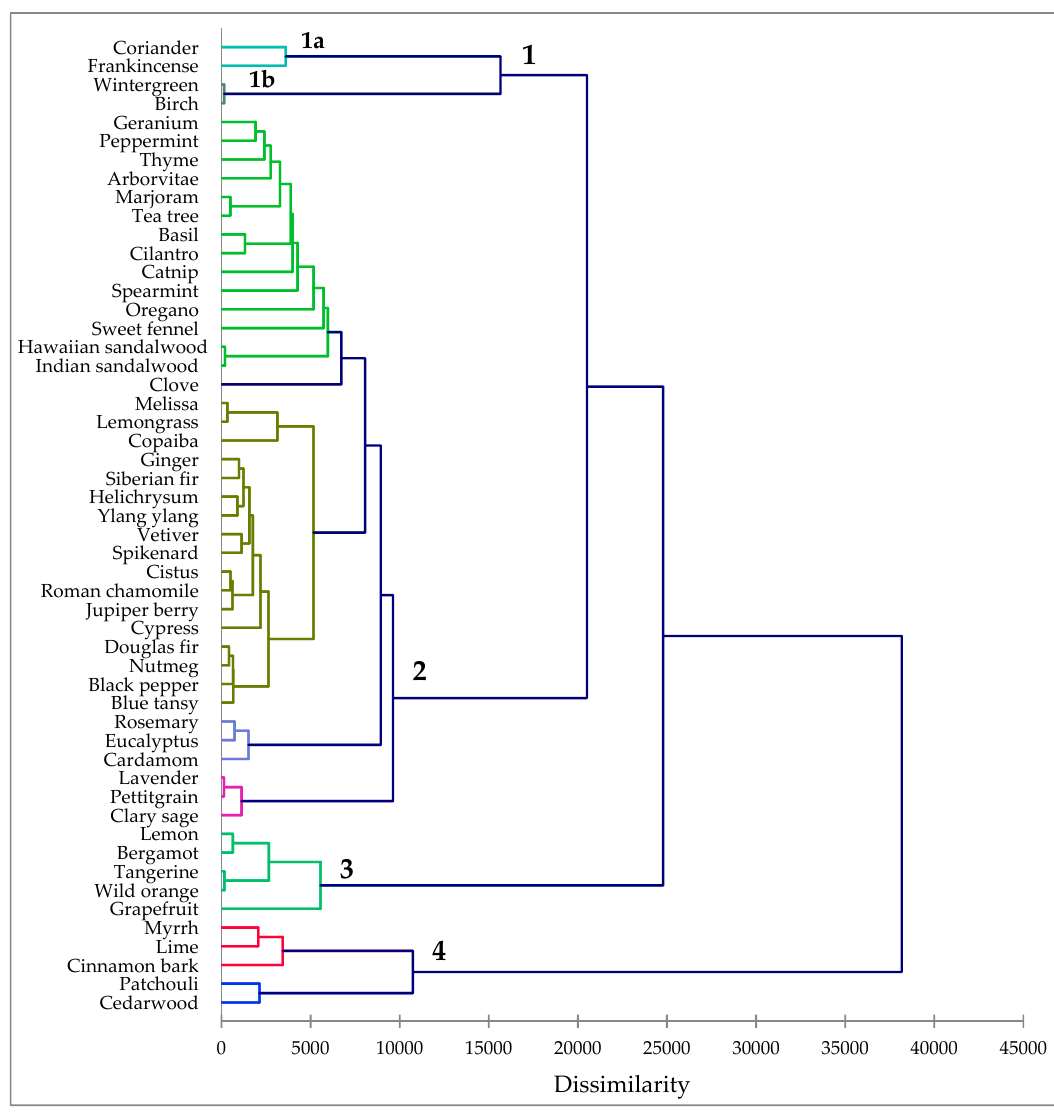
Figure 1. Dendrogram obtained from the agglomerative hierarchical cluster analysis of 52 commercial essential oil compositions and antileishmanial and cytotoxic activities.